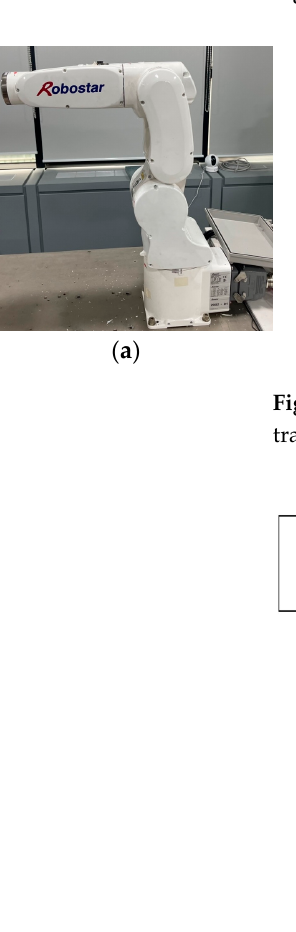
Table 2. Detailed information about the collected data.